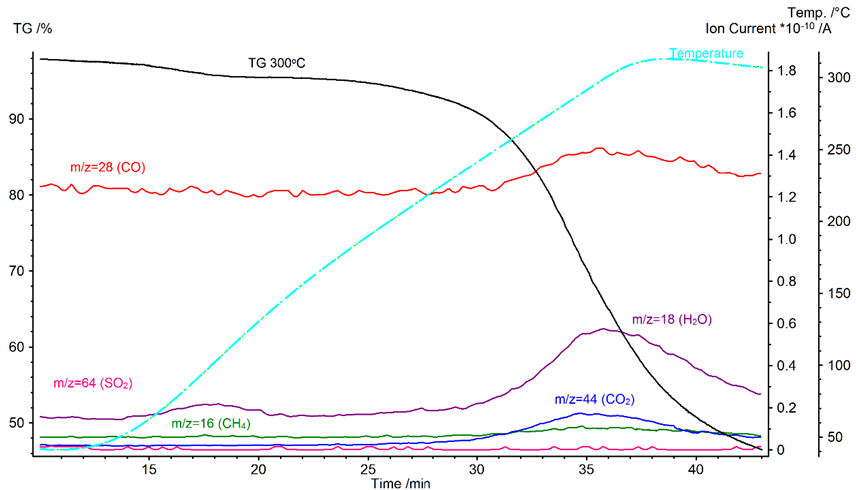
Figure A8. TG curve and ion current curves for the maize straw torrefaction process carried out up to 300 °C.